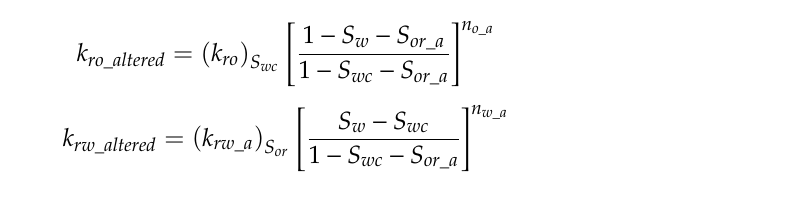
Table 2. Quantitative summary of the impact of the low salinity on the oil recovery through relative permeability parameters which was calculated from the published results of [20,21,23,25,26]. The Minimum and Maximum parameter values were computed from the references ’ results while the average was obtained arithmetically.